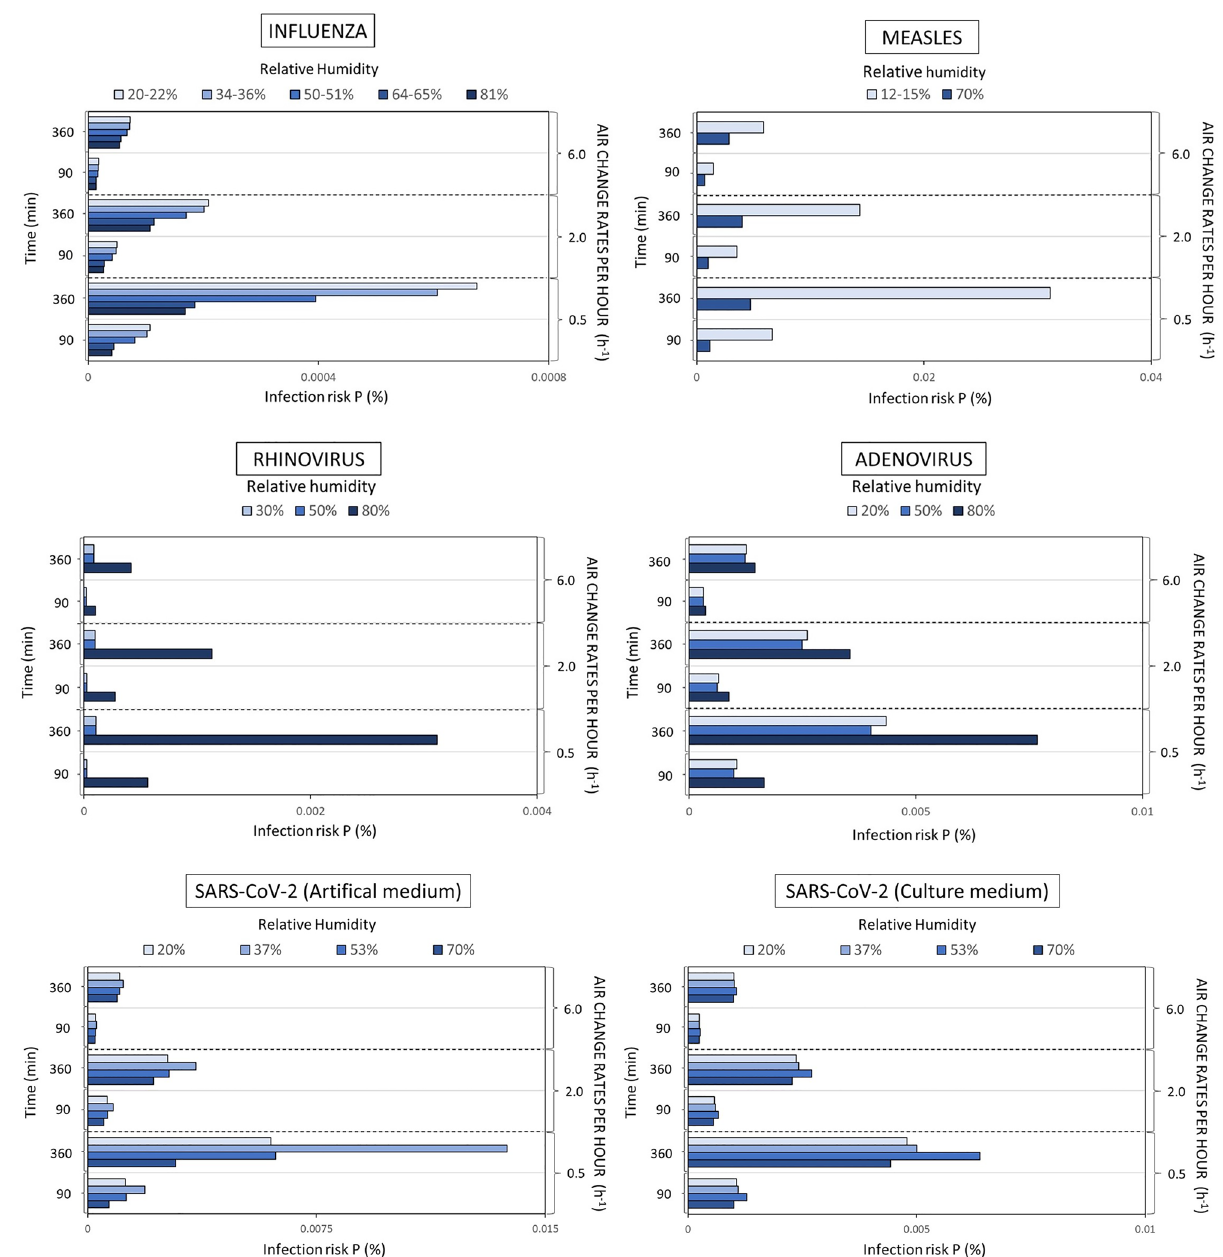
Figure 1. Impact of RH and ventilation rate on infection risk probability P when a person infected with, rhinovirus, adenovirus, SARS-CoV-2 with a dry solute composition consisting of artificial medium and SARS- CoV-2 when the aerosol dry solute composition consists of the culture